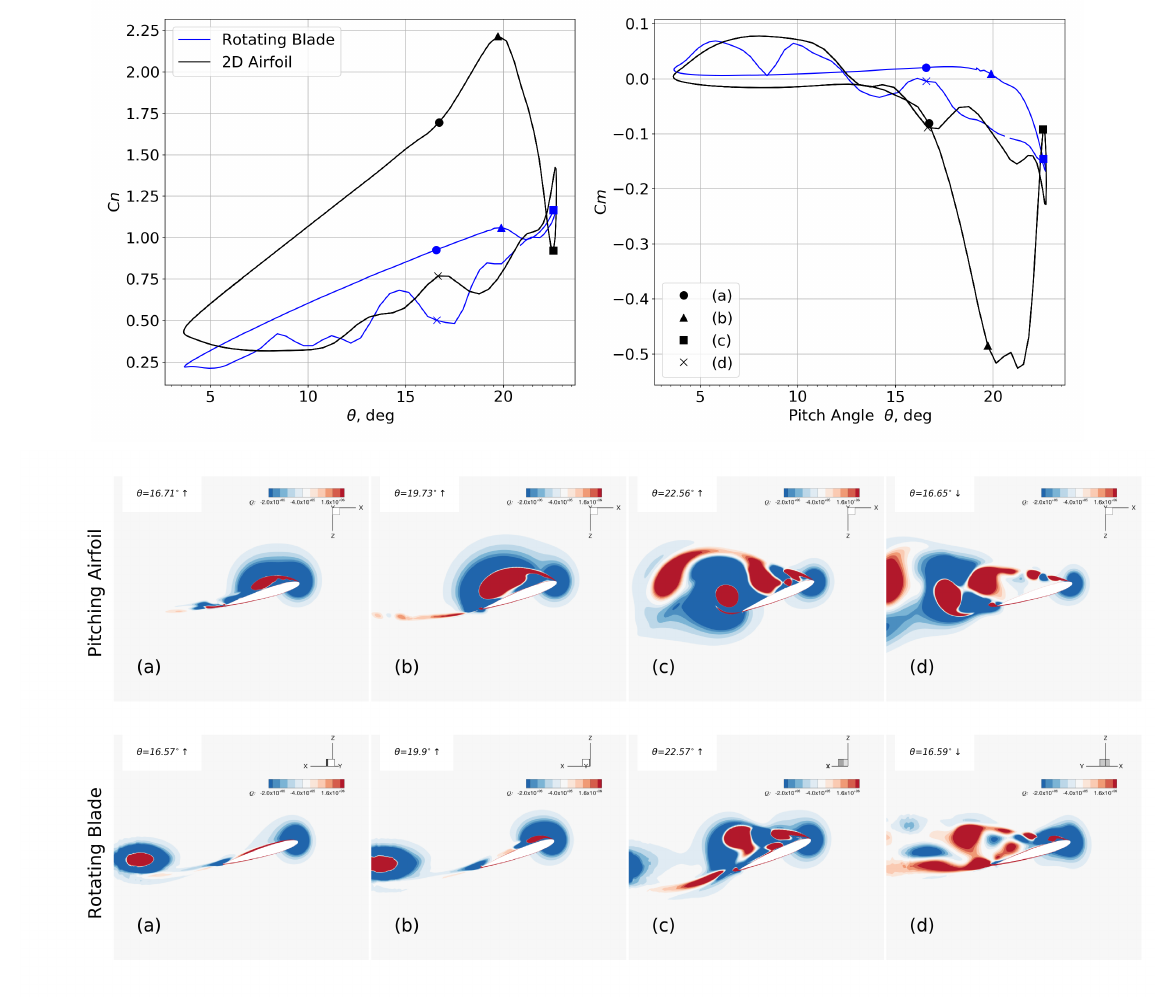
Figure 19. Up: Comparison of Sectional force coefficients on blade at r / R = 0.898 with the numerical simulation of non-rotating pitching blade and pitching airfoil. Down: vortical structure on pitching airfoil and the slice at radial location r / R = 0.898 of the rotating blade, shown as a contour of Q at selected pitch angles shown in the force plot. For rotating blade, these pitch angles correspond to azimuth angle ( a ) Ψ = 254 ◦ , ( b ) Ψ = 278.9 ◦ , ( c ) Ψ = 315 ◦ , ( d ) Ψ = 32.5 ◦ . The coordinate in the slice of the rotating blade is the inertial